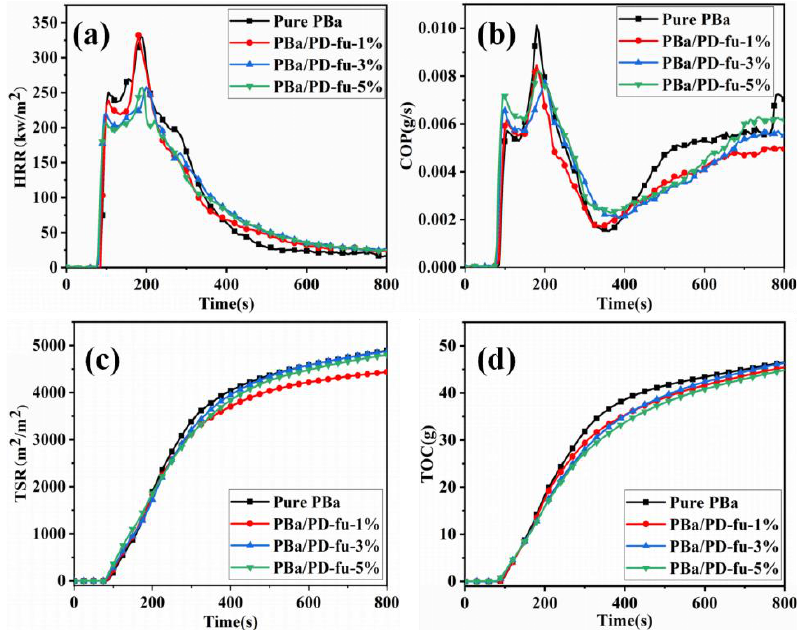
Figure 7. ( a ) HRR, ( b ) COP, ( c ) TSR and ( d ) TOC with respect to time for PBa and PBa/PCF composites based on the CONE calorimetry.